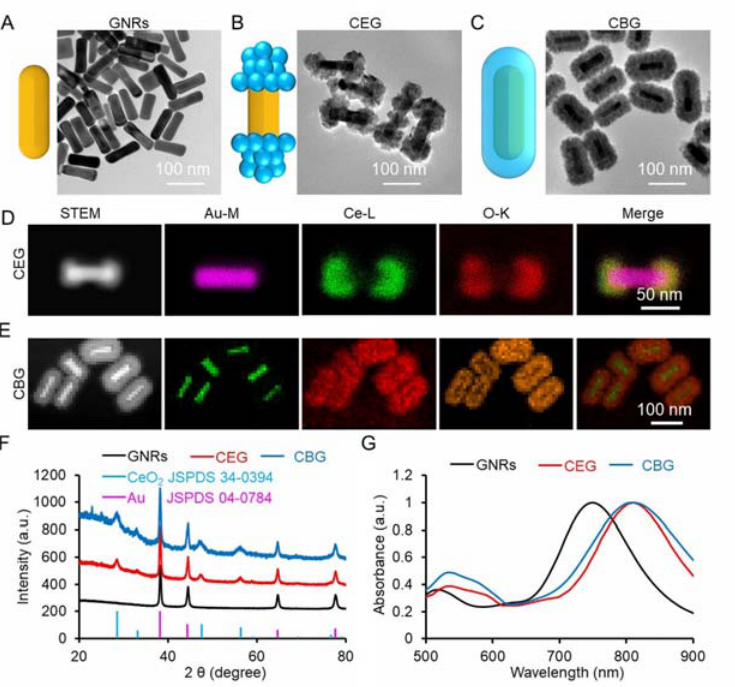
Figure 2. Physicochemical characterization of CEG and CBG NRs. ( A – C ) TEM images of GNRs, CEG, and CBG NRs, respectively. ( D , E ) STEM and EDS elemental mapping images of CEG and CBG NRs. ( F ) The XRD pattern of CEG and CBG NRs. ( G ) The UV-Vis-NIR absorption spectra of GNRs, CEG, and CBG.